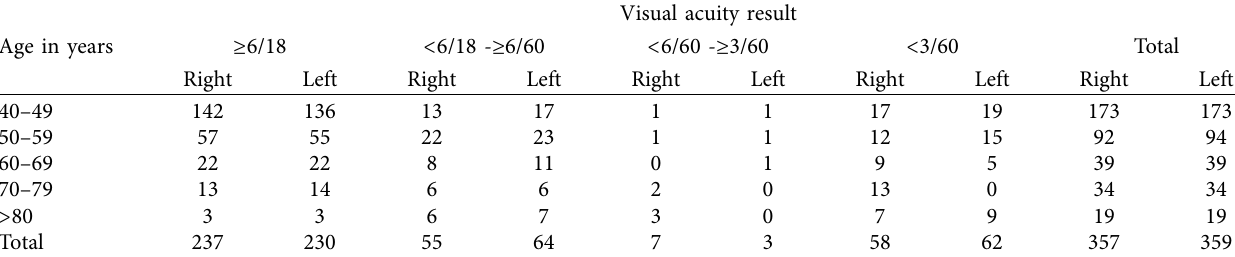
Table 3: Visual acuity result of left and right eye of participants in South Ari district, Southern Ethiopia, in December 2021.